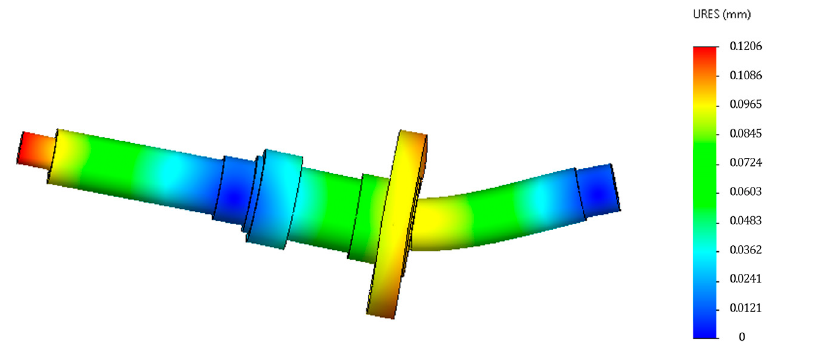
Figure 9. Second gear results: ( a ) boost; ( b ) recuperation.